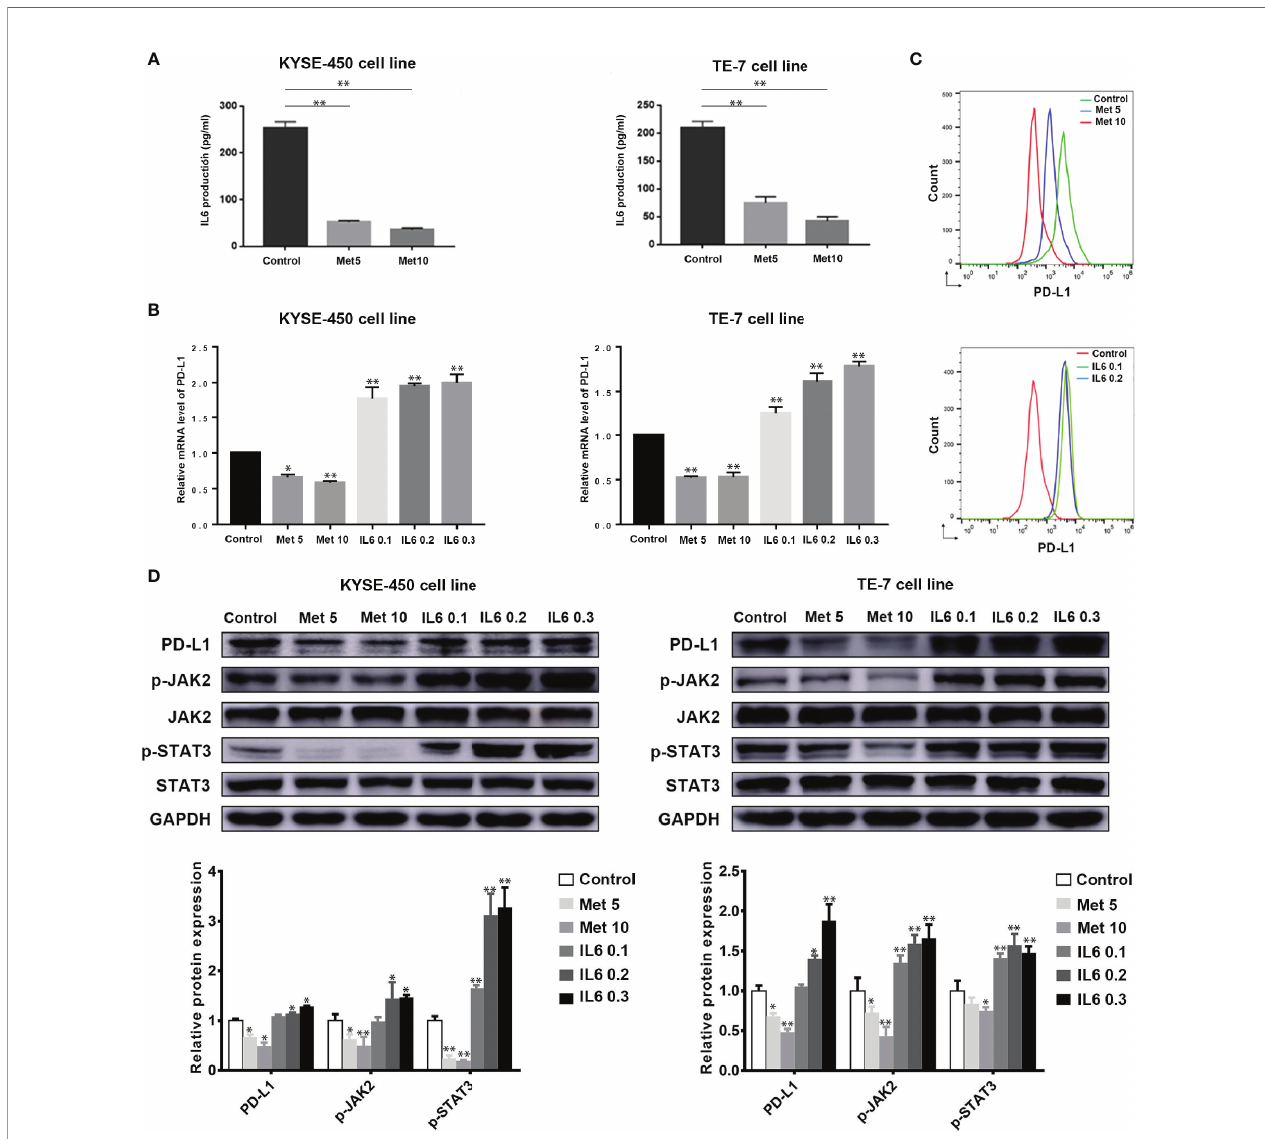
FIGURE 2 | Metformin suppresses the IL6 signaling pathway and downregulates the expression of PD-L1 in vitro . KYSE-450 and TE-7 cells were treated with increasing concentrations of metformin (5 to 10 mM), IL-6 (0.1 to 0.3 ng/ml) or PBS for 36 (h) (A) The expression of IL-6 in each group was detected by ELISA. (B) mRNA expression levels of PD-L1 in cells treated with metformin or IL-6 were analyzed by RT-PCR. (C) The expression of PD-L1 by fl ow- cytometric analysis after metformin or IL-6 treatment. (D) Western blot analysis and quanti fi cation of PD-L1, phosphorylated- Jak2 (p-Jak2), Jak2, phosphorylated- Stat3 (p-Stat3), Stat3, and GAPDH were performed. Error bars represent the standard deviation. *p < 0.05, **p <